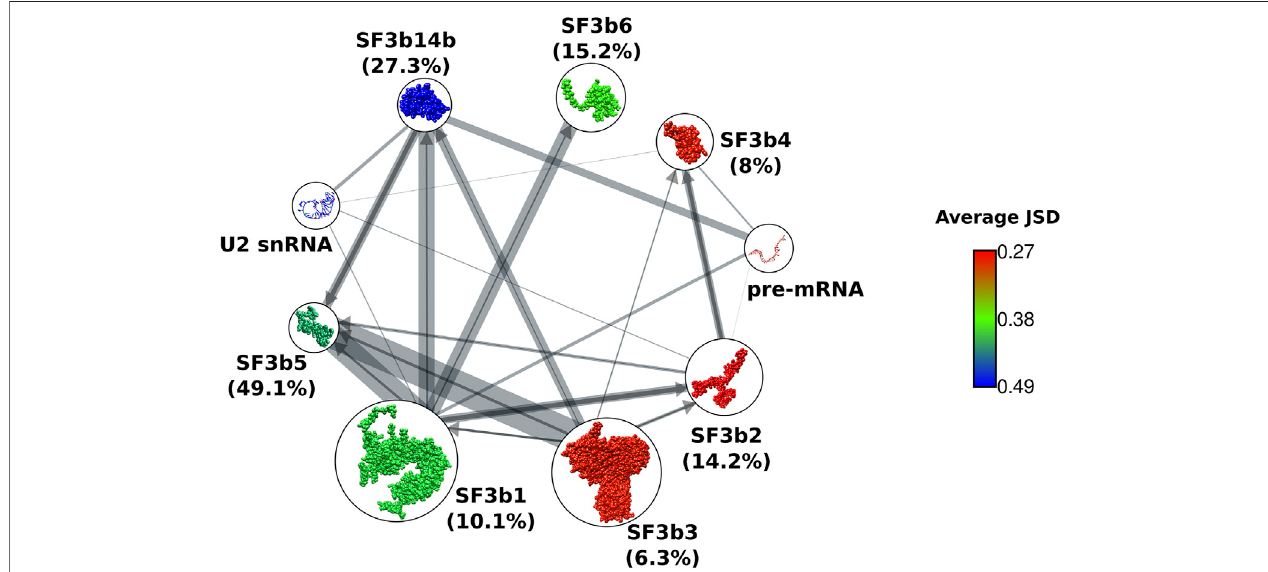
FIGURE2| SequenceconservationofSF3bproteins.Networkrepresentationofprotein-proteininteractionsbetweencomponentsofSF3bcomplex.Nodesshow cartoon representation of SF3b proteins and RNA molecules. SF3b proteins are colored based on their average JSD score. Edge width indicates the percentage of protein sequence covered in the interface region (refer Supplementary Table S2B ). To simplify representation of the bidirectional network, and an edge from a protein that shares a smaller percentage of sequence at the interface is indicated by an arrow (dark grey), while the edge from its partner having a higher percentage is indicated by a line without an arrow (light grey). Total percentage of protein sequence involved in the interface is indicated within brackets next to the node labels. Core components have higher percentages (SF3b14b and SF3b5) than the peripheral components (SF3b1, SF3b2, SF3b3, SF3b4 and